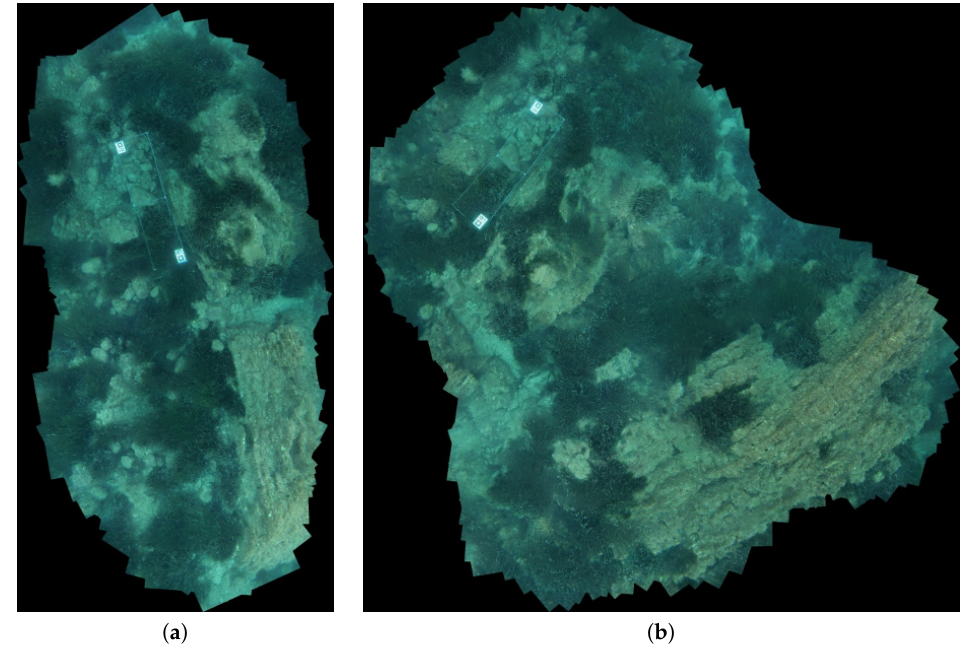
Figure 8. ( a ) Photo-mosaic of S 21. ( b ) Photo-mosaic of S